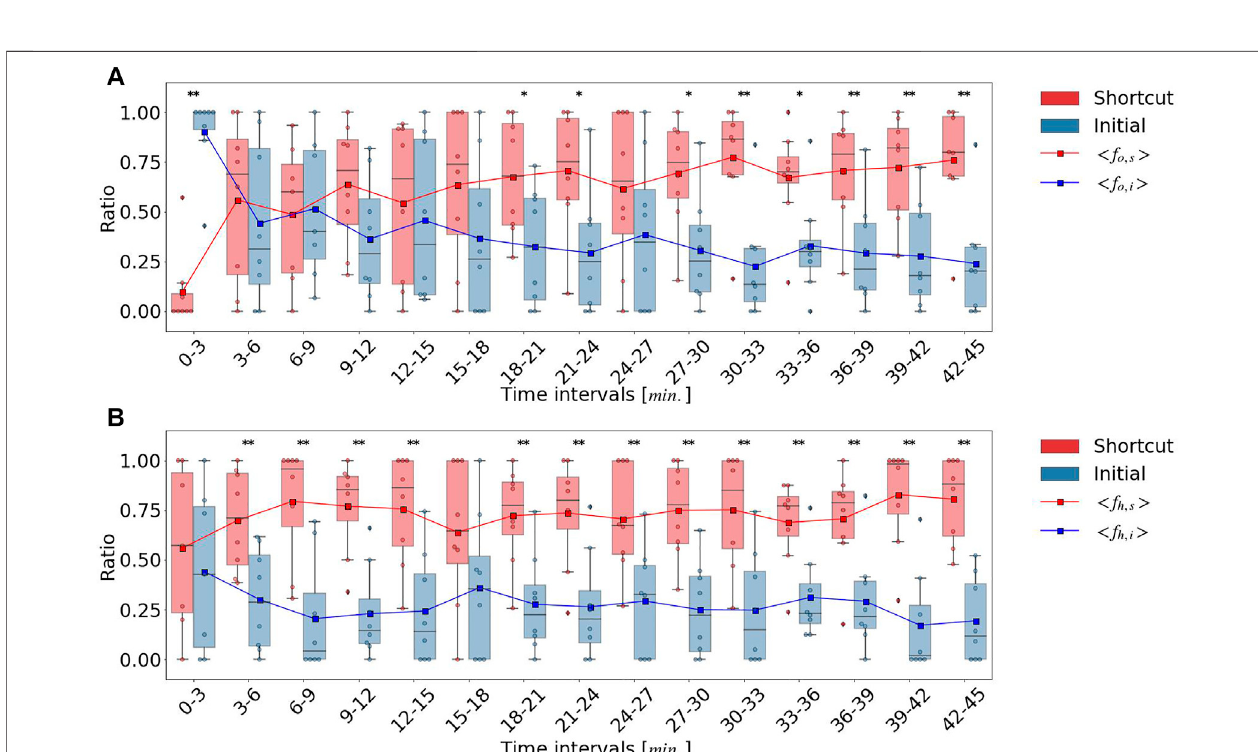
FIGURE 5 | Ratio between the number of ants passing each decision line: (A) outward ants. (B) homeward ants.